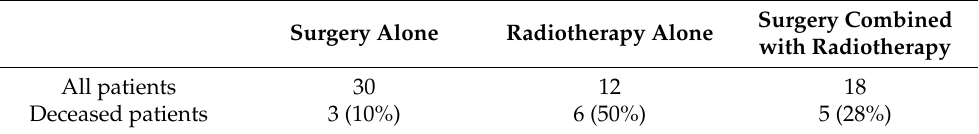
Table 2. Number of deceased patients in each treatment group. Surgery Combined Surgery Alone Radiotherapy Alone with Radiotherapy All patients 30 12 18 Deceased patients 3 (10%) 6 (50%) 5